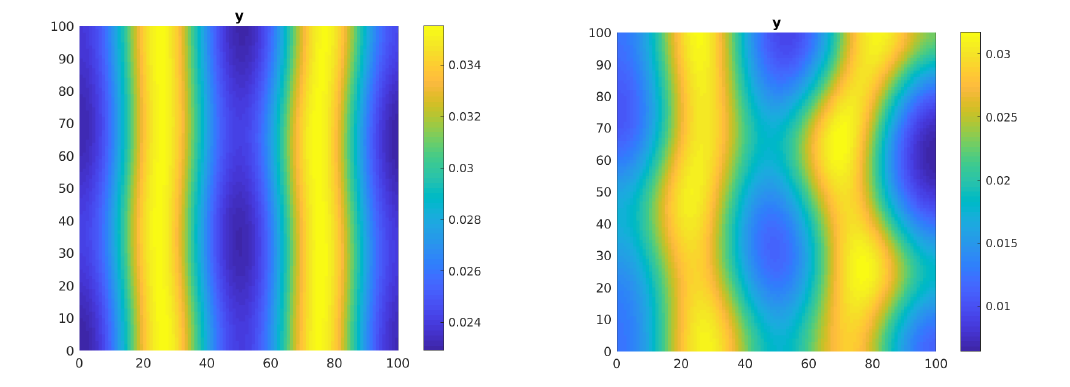
Figure 11. Plots of the solution y of system (2)–(5) in the same parameter setting of Example 2 apart from η = 0.1, T = 6000 ( left panel ) and η = 1, T = 4000 ( right panel ). Here γ 11 = 1, γ 22 = 10, γ 12 = 0.1 and γ 21 = 1.3. The corresponding equilibrium values for the ODE system (1) are (0.1734, 0.0305) and (0.1374, 0.0243),